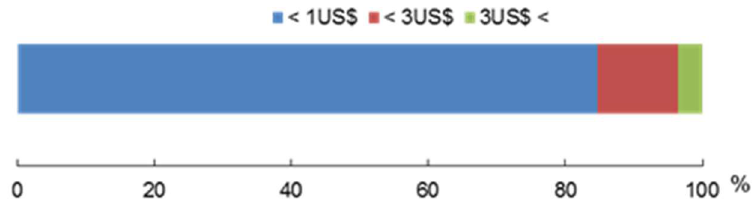
Figure 10. Average monthly income of the families interviewed in Mwazisi ( n = 399).